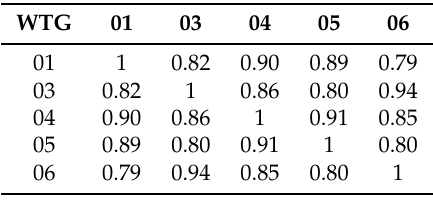
Table 1. Matrix of model input variables correlation coefficients.